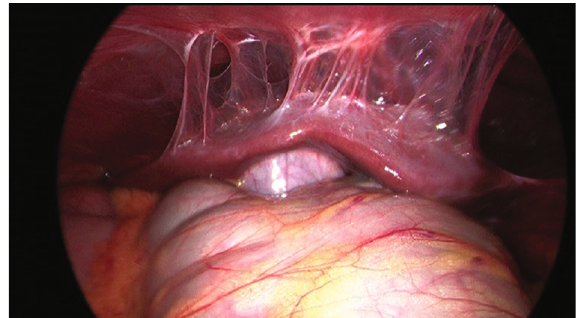
Figure 2: Perihepatic adhesions above the left and right lobes of the liver, consistent with Fitz-Hugh-Curtis syndrome.